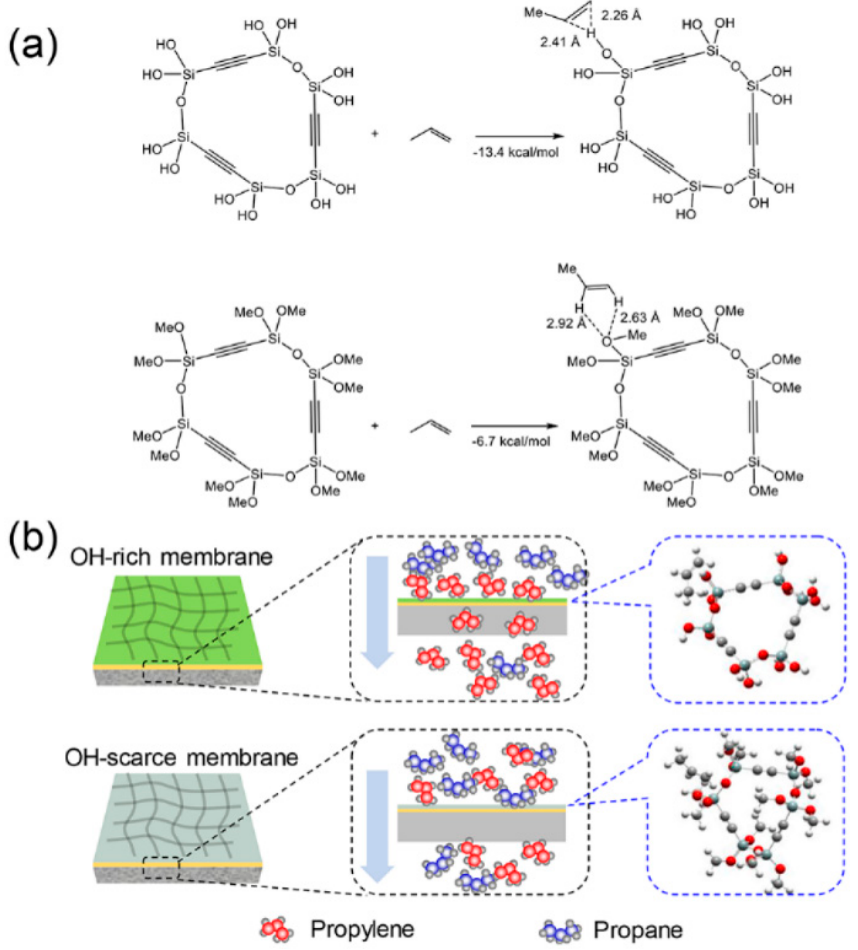
Figure 15. ( a ) Model reactions cyclic trimers and optimized geometries of propylene complexes. ( b ) Plausible C 3 H 6 /C 3 H 8 separation mechanisms through BTESA membranes with different chemi- cal properties [45].